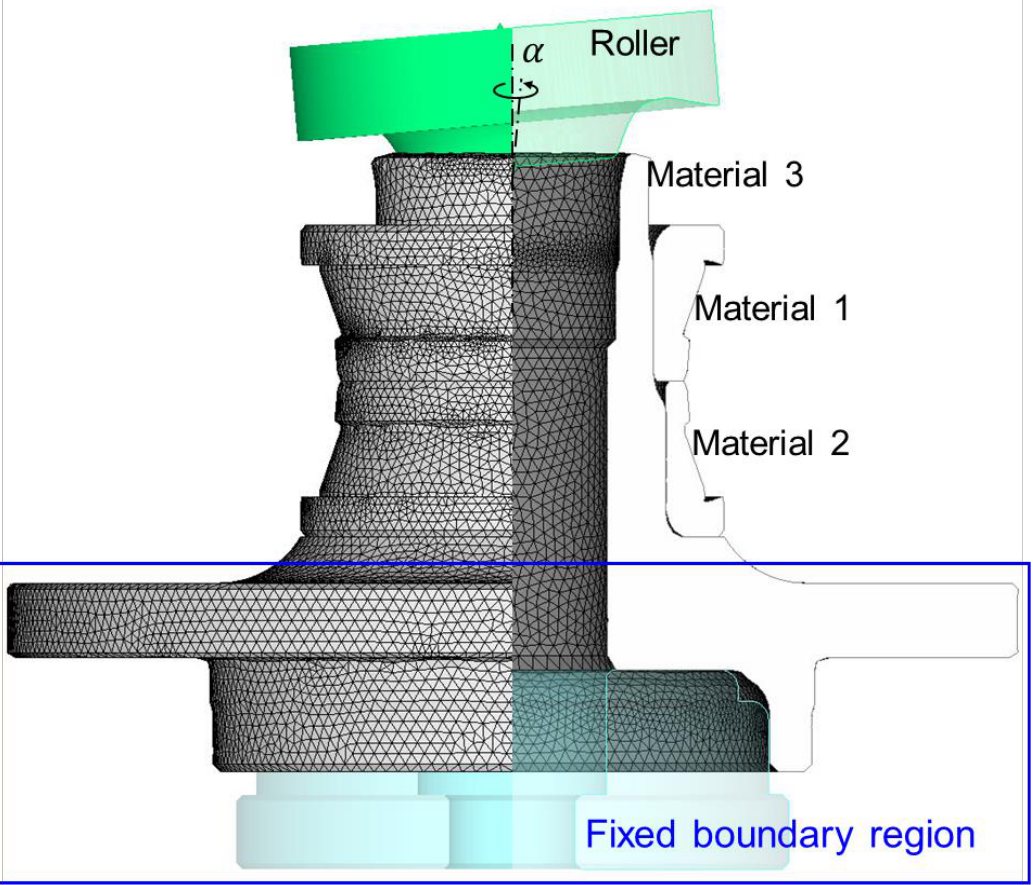
Figure 4. The FE analysis